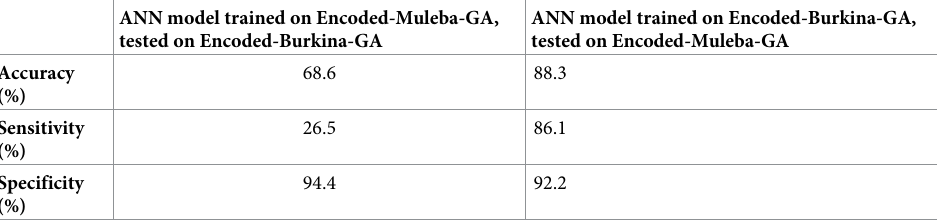
Table 6. Independent testing of ANN models trained on Muleba-GA and Burkina-GA encoded